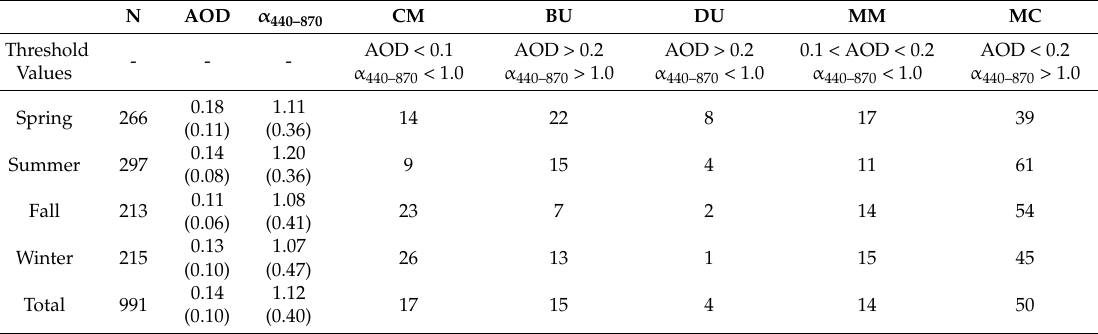
Figure 4. Daily mean values of ( a ) the aerosol optical depth at 500 nm (AOD) and ( b ) Ångström coefficient computed between 440 and 870 nm ( α 440 − 870 ) in the period from December 2008–May 2015 at the Aerosol Robotic Network (AERONET) Arcachon lagoon station. Red dotted lines represent the low-pass filtered data performed with running averages. Table 2. Mean values (standard deviation) of the aerosol optical depth at 500 nm (AOD), the Ångström coefficient ( α 440 − 870 ) and proportion (%) of the different aerosol types (CM: clean maritime; BU: biomass burning/urban-industrial; DU: desert dust; MM: mixed maritime; and MC: mixed continental) as a function of the season. Note that decimal values for proportions are not significant because the choice of threshold values is partly arbitrary (based on the literature, ± 0.02 for AOD and ± 0.2 for α 440 − 870 ). N is the number of